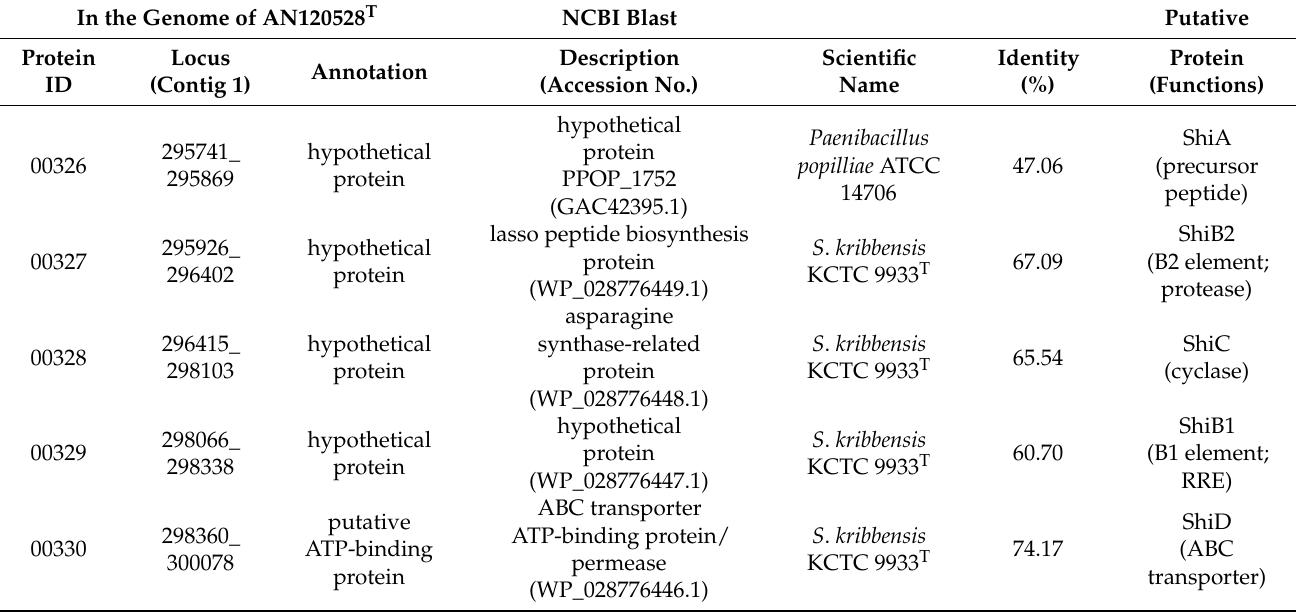
Table 4. Proposed functions of the open reading frames in the putative lasso peptide biosynthetic- related proteins of AN120528 T